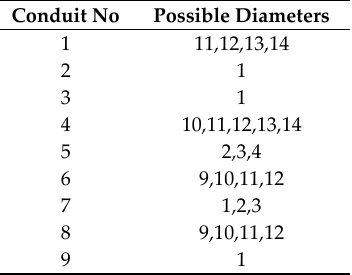
Table 3. Possible